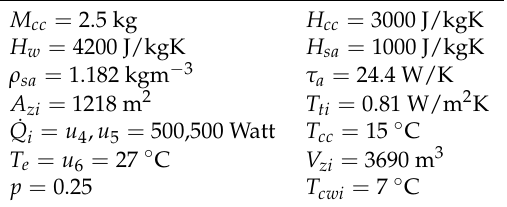
Table 3. Numerical values of variable air volume system parameters on the operating